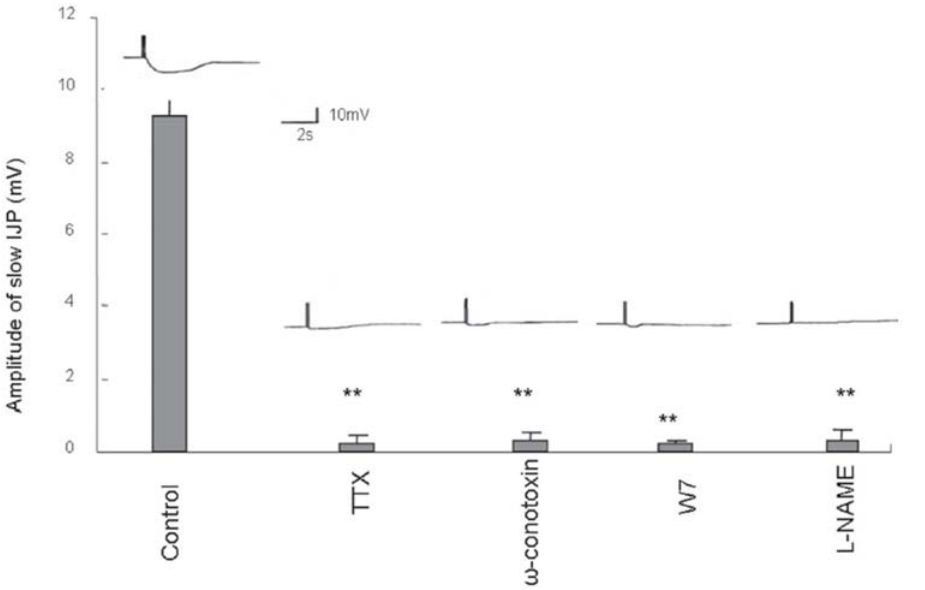
Figure 5. Effect of various antagonists on the slow IJPs in mice gastric muscle strips. The slow IJP was produced in response to EFS under NANC conditions. Note that the slow IJP was suppressed by pretreatment with TTX and v -CTX GVIA but nifedipine had no effect (data not shown). Moreover, calmodulin antagonist, W7 and nNOS inhibitor, L-NAME also blocked the slow IJP. Representative sIJPs are shown at the top of the bar of the respective treatment